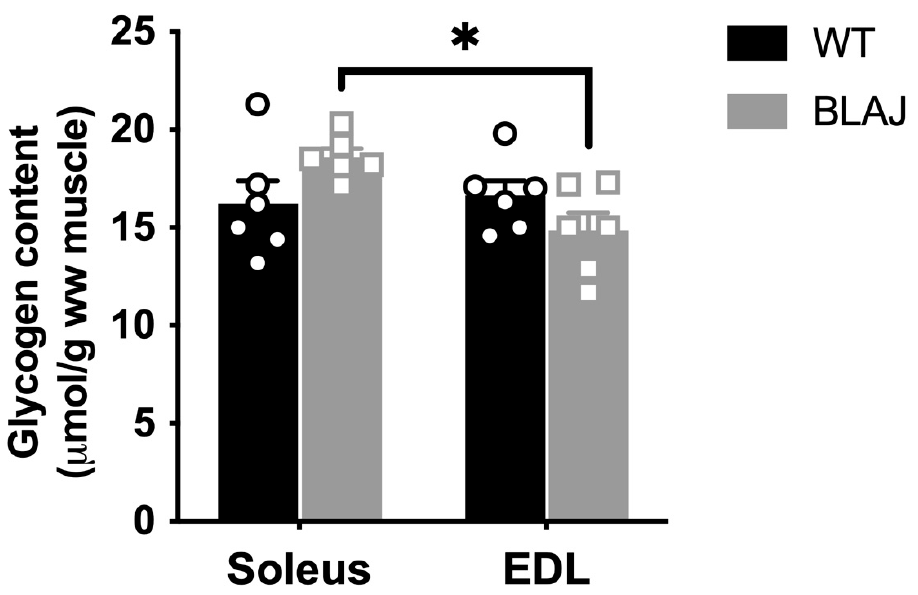
Figure 3. Glycogen content in soleus and EDL muscles of WT compared with dysferlin-deficient BLAJ male mice aged 10 months. Whole muscle homogenates analyzed for glycogen content. Data analyzed by two-way Analysis of Variance (ANOVA) with Holm-Bonferroni multiple comparisons: * BLAJ soleus vs BLAJ EDL ( p < 0.05). Data are presented as individual values (WT as circles, BLAJ as squares) and mean ± SEM ( n = 6).